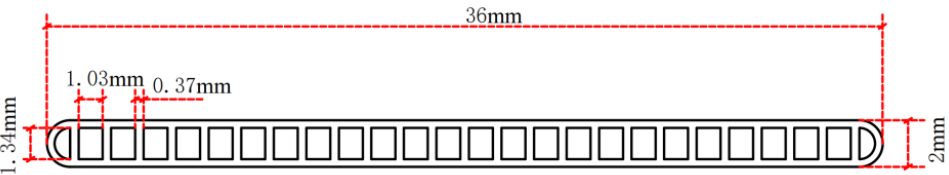
Figure 3. Single flat pipe size.